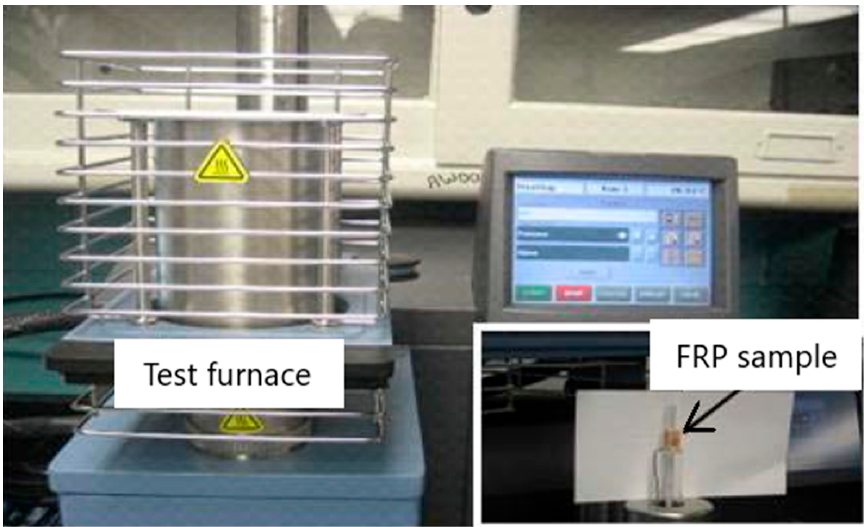
Figure 2. Experiment setup for thermo-mechanical analysis (TMA).